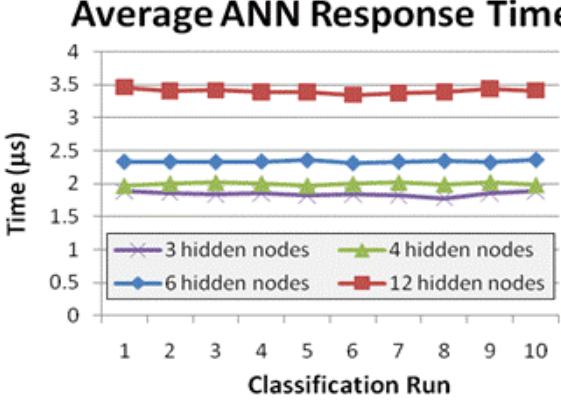
Fig. 5: ANN Average Response Times ( μ seconds)